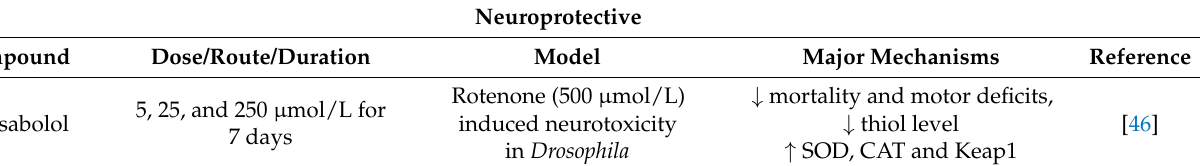
Table 4. Neuroprotective effects and underlying mechanisms of α -Bisabolol.